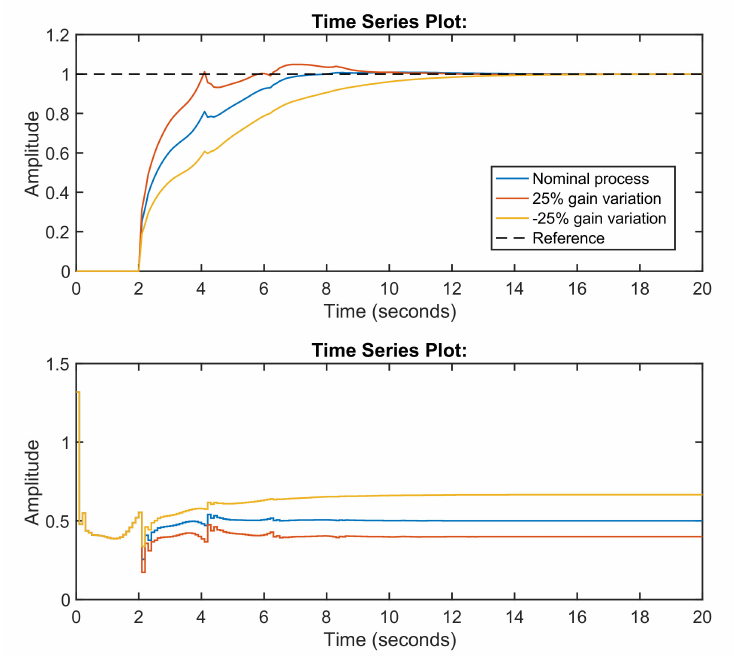
Figure 12. Robustness validation of the event-based FO-IMC controller (output signal in the upper plot, input signal in the lower plot).